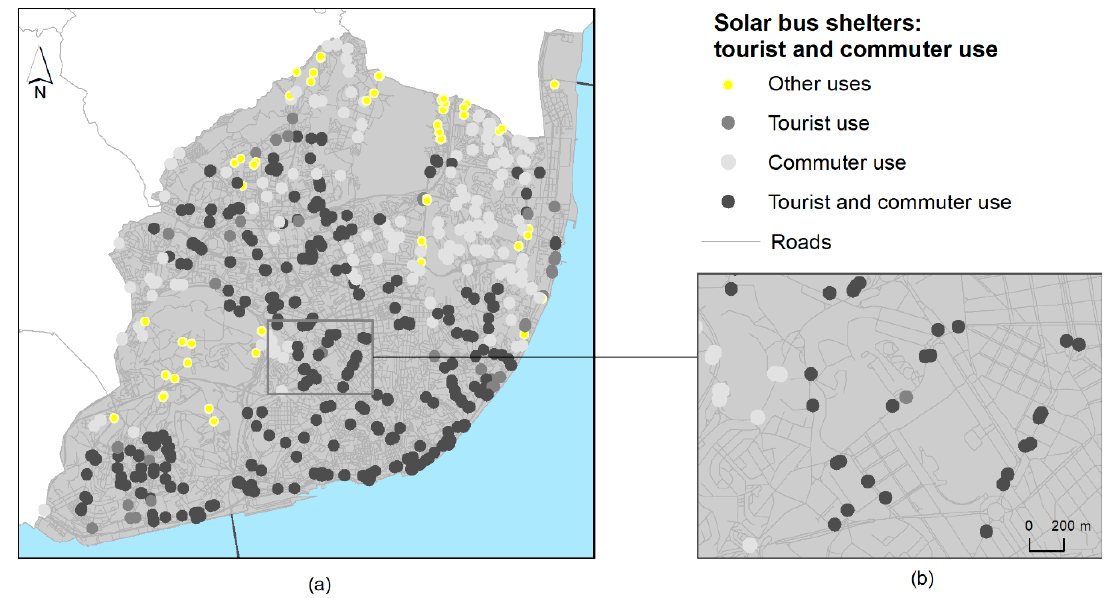
Figure 11. Solar bus shelter locations according to tourist and commuter use ( a ), and close-up view of a neighborhood ( b ).